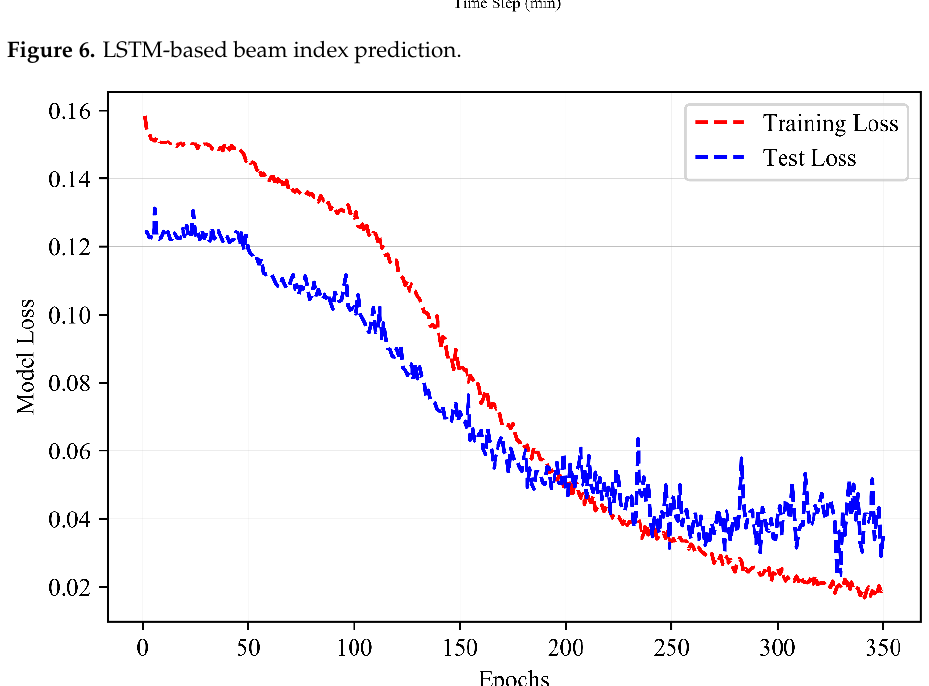
Figure 7. LSTM-based model loss.